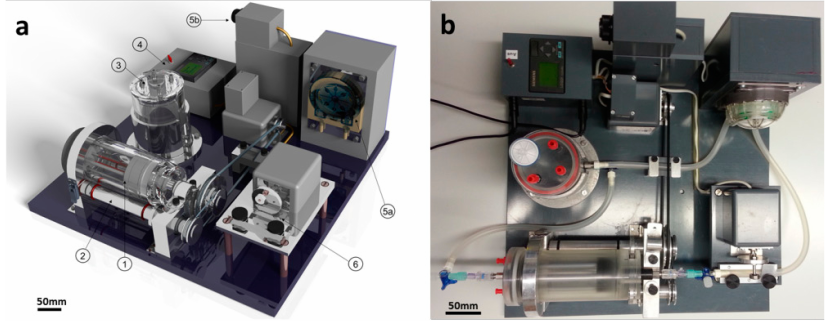
device (1), rotating mixer (2), media reservoir (3), control unit (4), roller pump (5a) with potentiometer (5b) and pulse generator (6) and ( b ) the assembly of the all-in-one bioreactor (BR) with connection of all subunits via a simple tubing system.